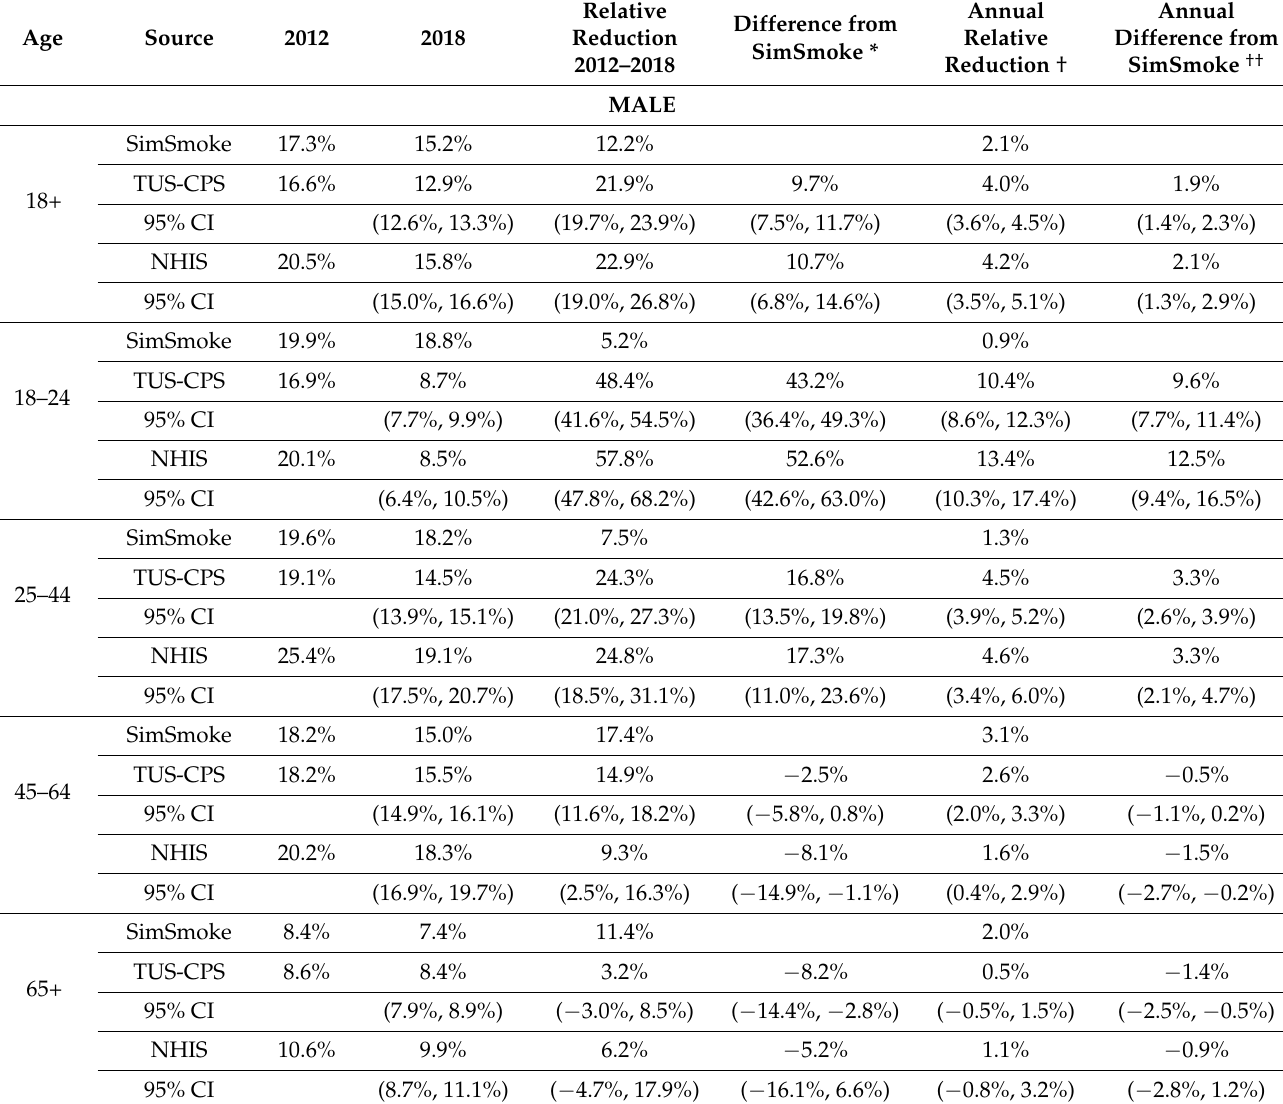
Table 3. Smoking prevalence predictions from No-NVP SimSmoke Counterfactual compared to national surveys, by age group and gender,